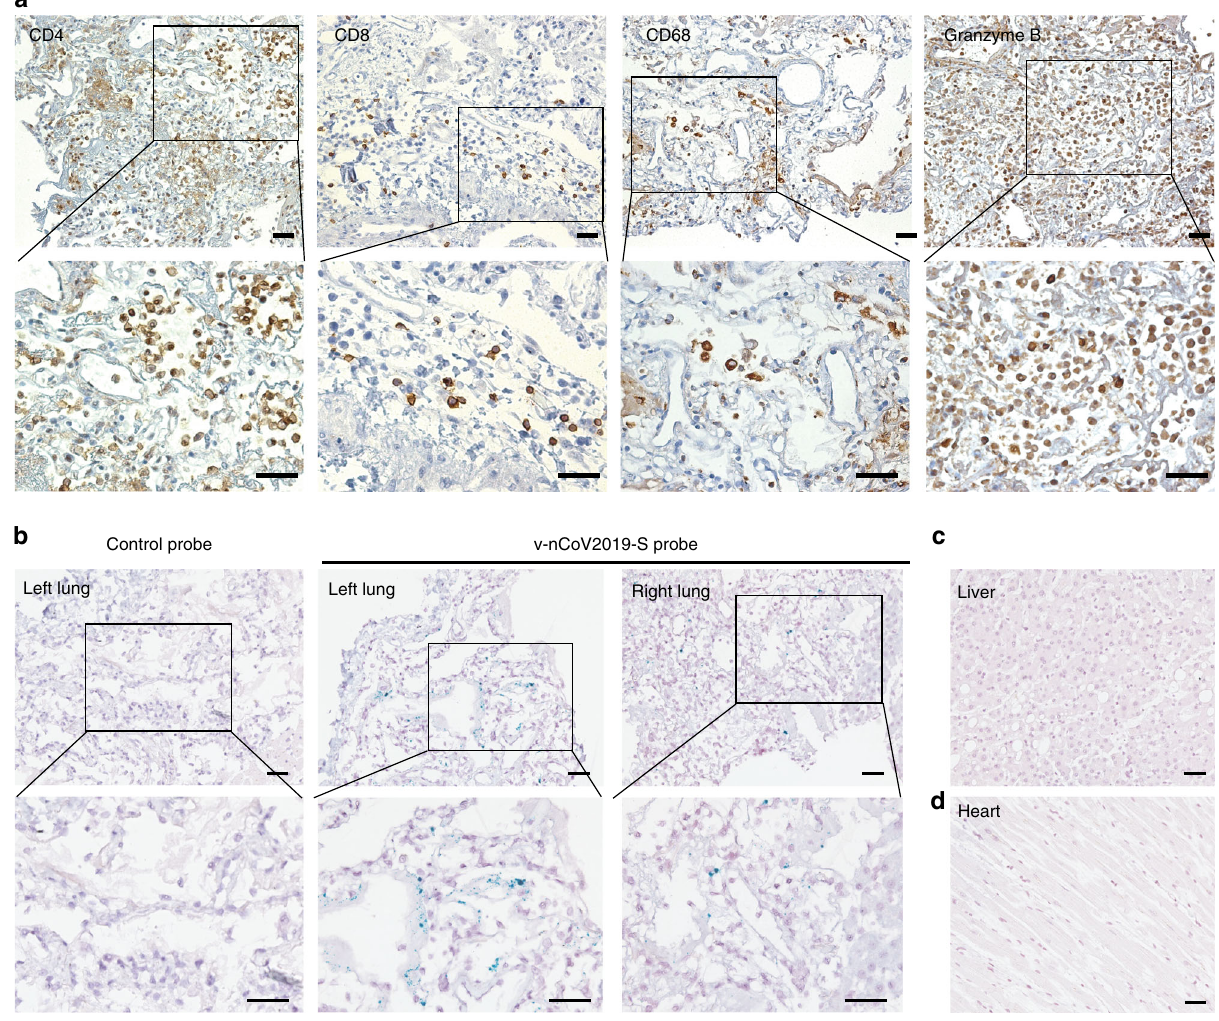
Fig. 5 Lymphocyte in fi ltration and viral distribution in lung. a Immunohistochemical staining with anti-CD4, anti-CD8, anti-CD68 and anti-GZMB in lung tissues, scale bar = 50 μ m. b – d Representative microscopy images of both left and right lungs ( b ), liver ( c ), and heart ( d ) sections from a COVID-19 patient hybridized with control or SARS-CoV-2-speci fi c probes, scale bar = 50 μ m. Independent experiments are repeated at least three